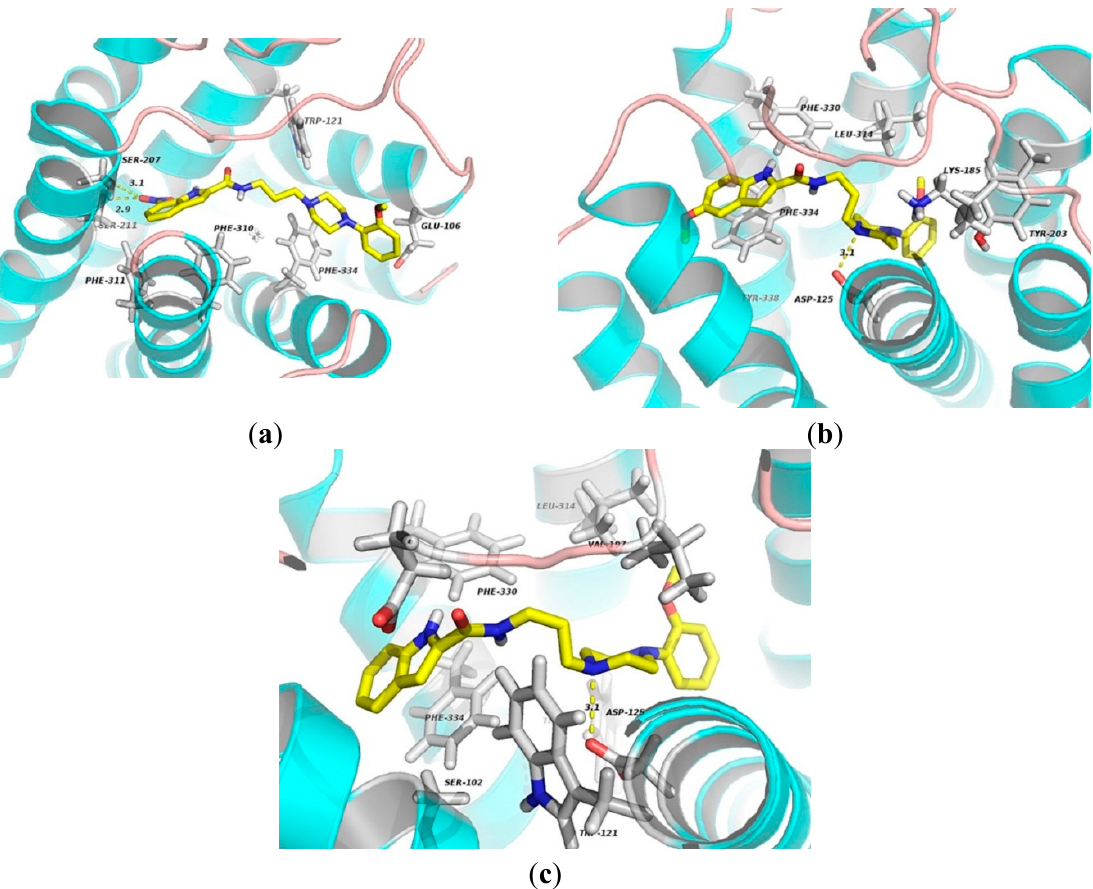
Figure 12. The docking complexes of ligands 1 ( a ); 2 ( b ); and 3 ( c ) with α 1B -AR. These compounds are shown in stick representation. The elements are coloured as follows: oxygen, red; nitrogen, blue; carbon, yellow. Dashed lines represent the hydrogen bonds or electrostatic